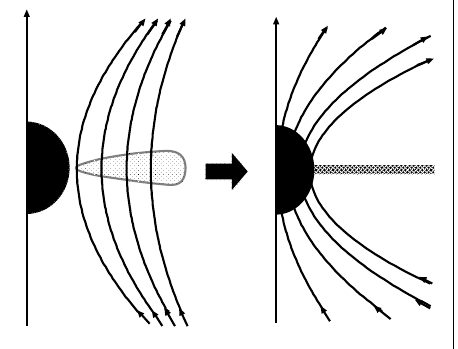
Figure 1. The formation of the magnetosphere is described by the split-monopole solution near a black hole. Accreting matter on the equator drags the global magnetic field ( left panel ). Next, a split-monopole-like magnetosphere is formed ( right panel